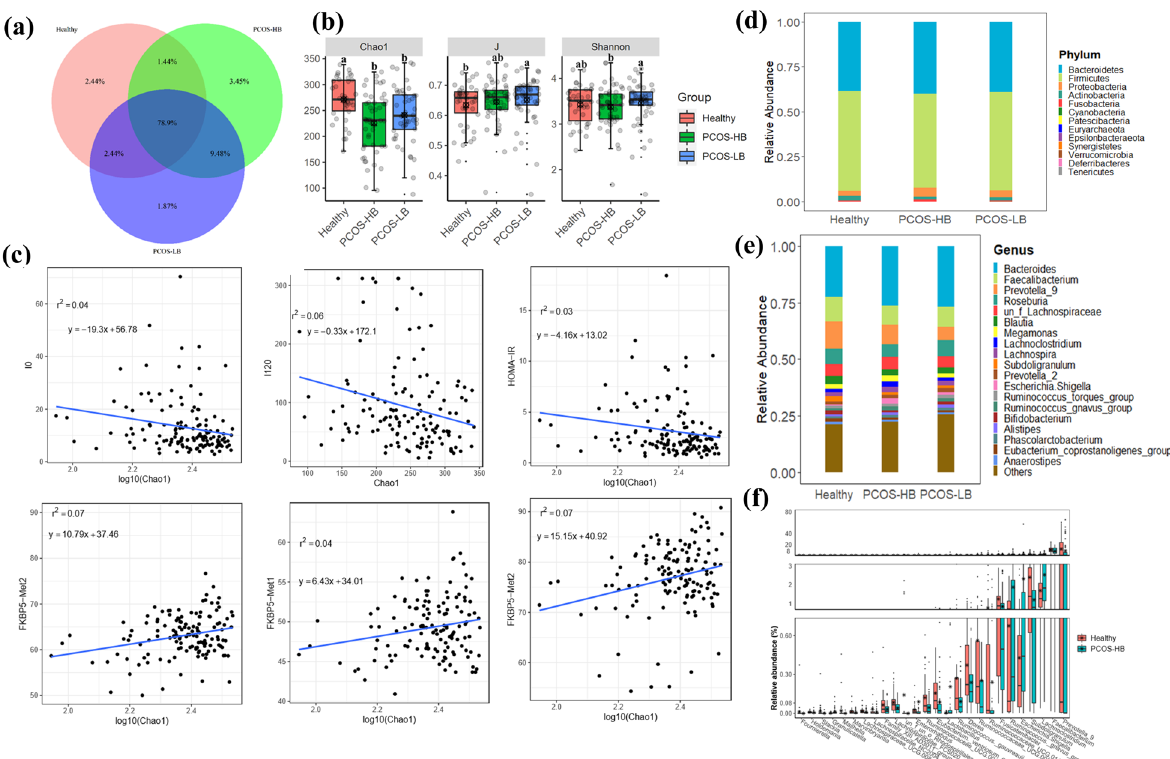
Fig. 2 Changes in bacterial diversity and community composition. a Venn diagram showing the shared and unique OTUs among healthy, PCOS-HB and PCOS-LB subjects. b The bacterial diversity comparison among healthy subjects, and subjects with PCOS-HB and PCOS-LB, respectively. The data are shown as the mean ± SD and error bar was used. c The association between bacterial diversity and clinical indices. d Distribution of bacterial taxa at the phylum level. e Distribution of bacterial taxa at the genus level. f The distinguished bacterial genera screened by the Wilcoxon test. Letters indicate the ANOVA grouping. Red, green, and blue color represent Healthy, PCOS-HB and PCOS-LB group separately. PCOS-LB, normal BMI (BMI < 24); PCOS-HB, high BMI (BMI ≥